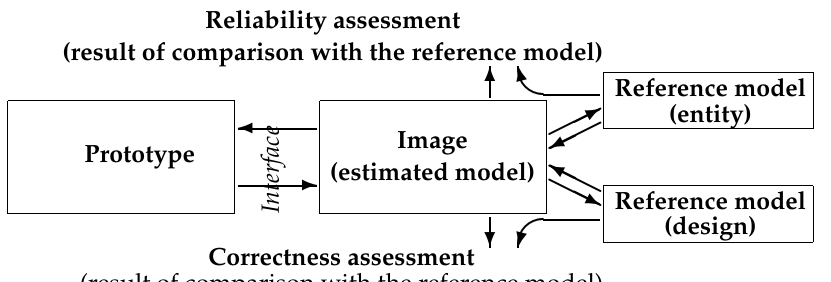
Figure 11. Illustration for the concept of “model of